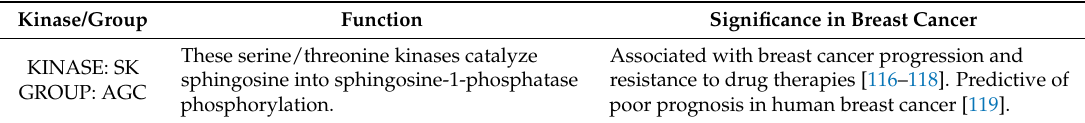
Table 9. Sphingosine kinases alterations and significance in breast